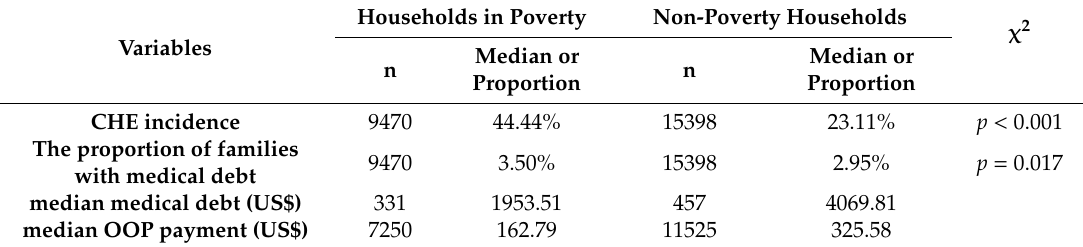
Table 2. Catastrophic Health Expenditure Incidence and Medical Debt among Poverty and Non- Poverty Households.